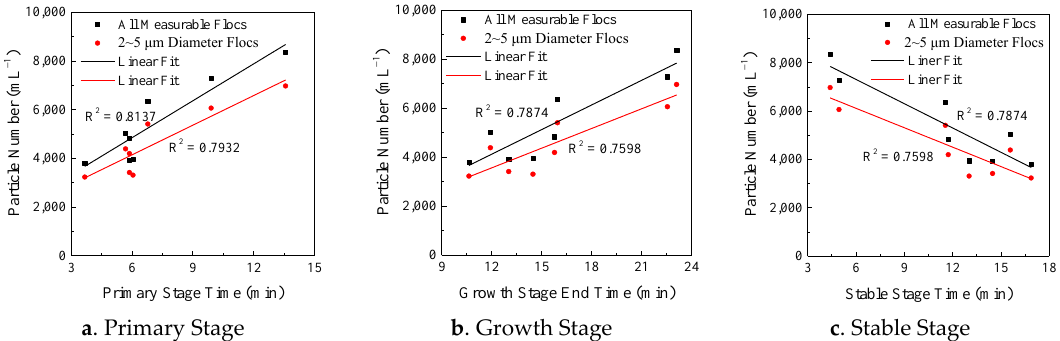
Figure 8. Linear fit between the particle number in settled water and the duration of the coagulation stage. ( a ) In the primary stage; ( b ) in the growth stage; and ( c ) in the stable stage.